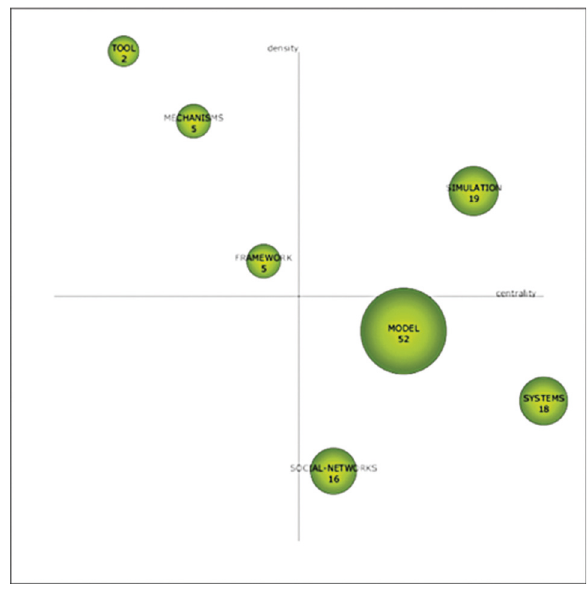
Figure 18: 2011–2015 strategic coordinate chart.